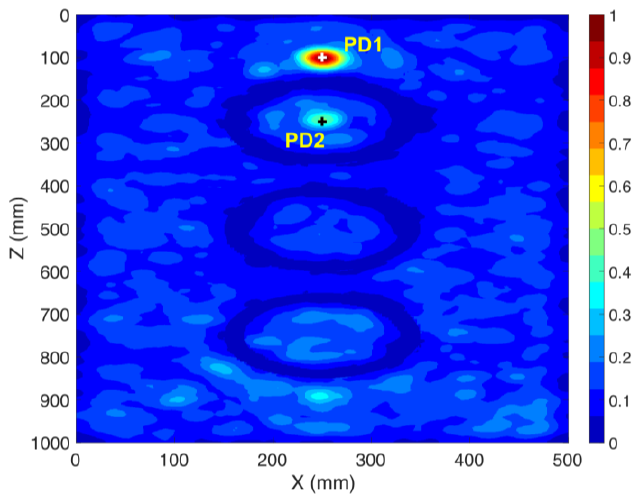
Figure 7. Normalized distribution of the maximum electric field power over the complete simulation time inside the transformer tank in the x-z cut plane (CS #5). The active parts of the transformer are included. The ground truth locations of the PD sources (PD1 and PD2) are shown by “ + ” markers. Only one sensor (S1) is used.